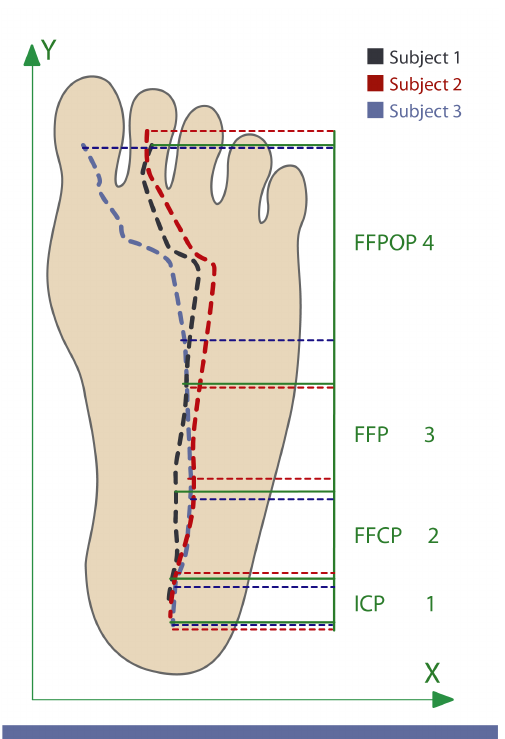
Figure 2. Correlation between center of pressure (CoP) position and gait subphases in the stance phase. Different colors show different subjects’ CoP